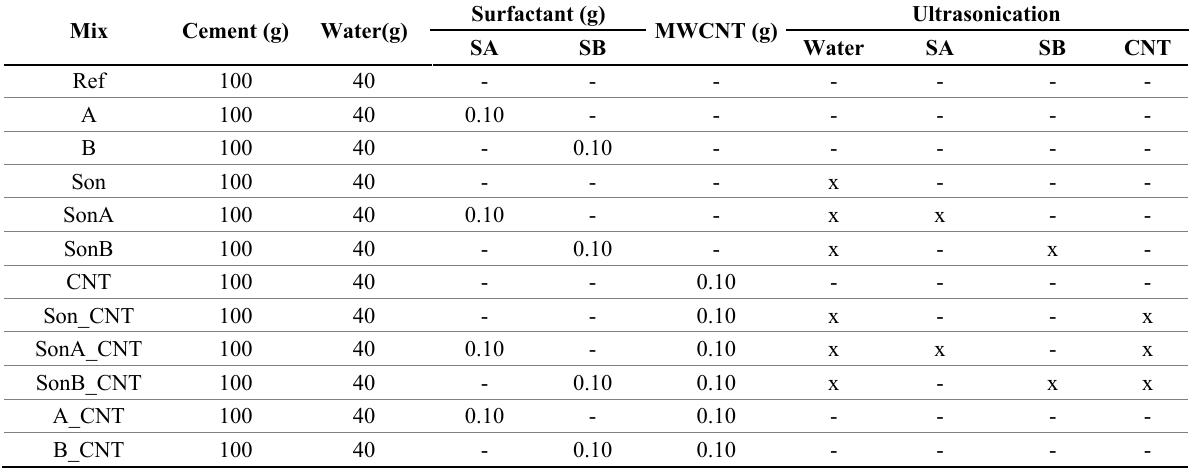
Table 2. Mixture compositions of Portland cement